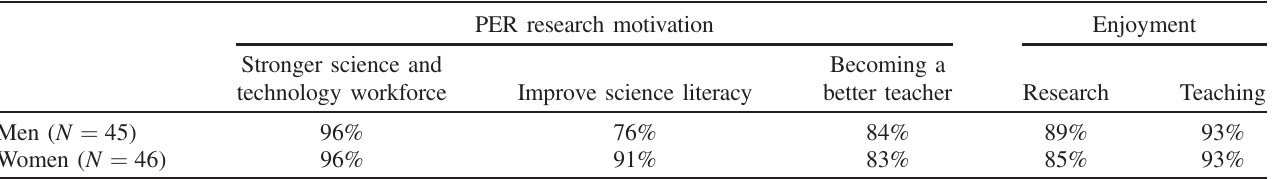
TABLE IV. Student motivation to do PER research and enjoyable